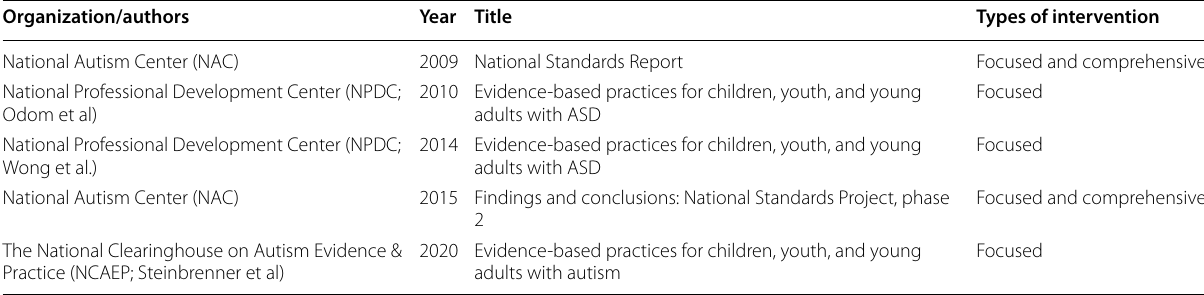
Table 1 Documents/authors, year of publication, document title, and types of intervention that were analyzed